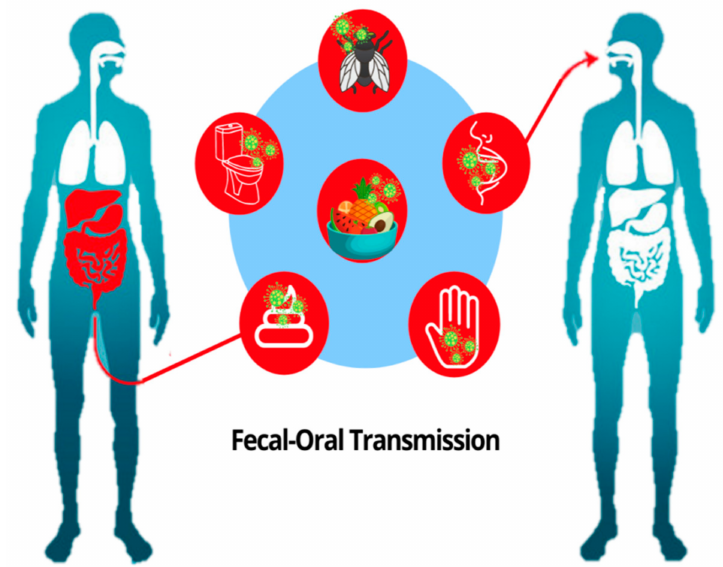
Figure 5. Fecal–oral COVID-19